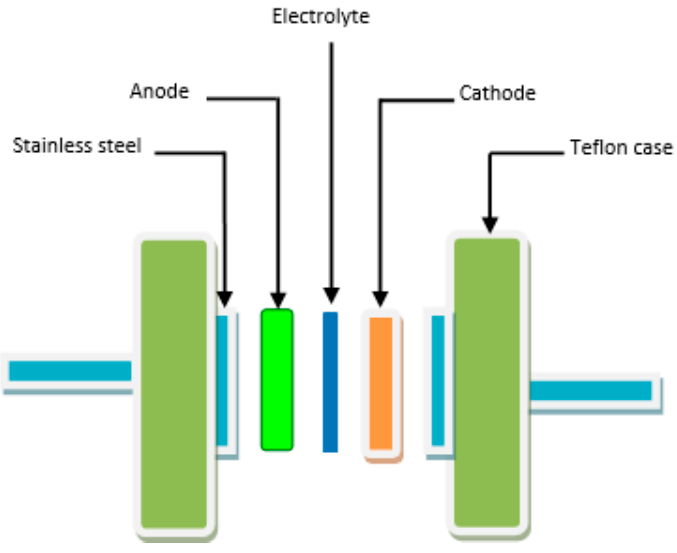
Figure 14. Schematic representation of the fabricated EDLC cell.